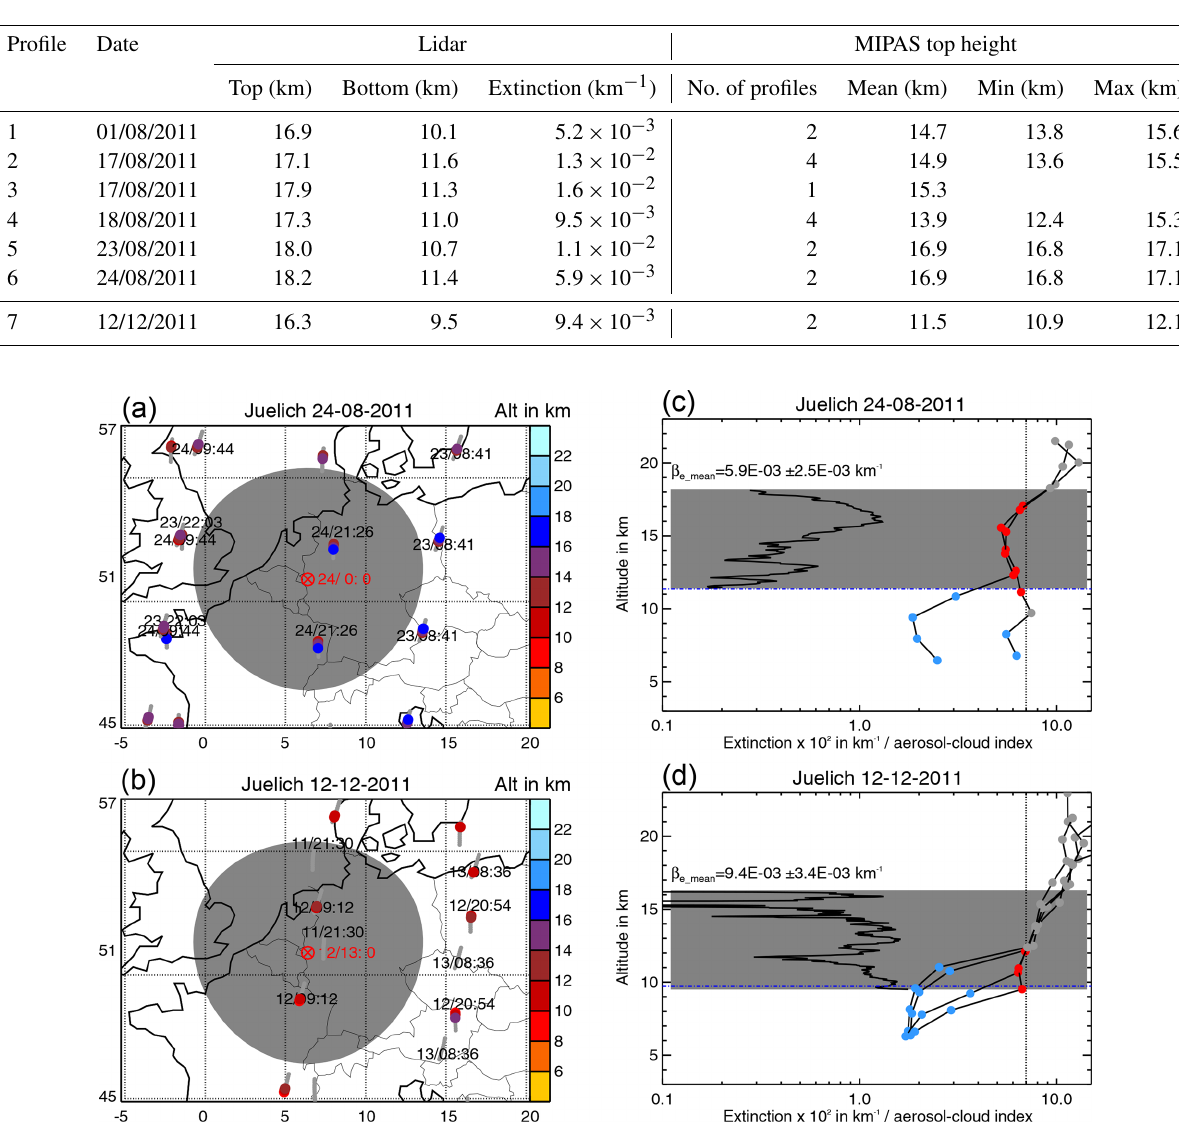
Figure 12. Nabro aerosol measured by the Jülich lidar and MIPAS on (a, c) 24 August 2011 and (b, d) 12 December 2011. (a, b) The maps show the lidar station, lidar measurement time, match radius, MIPAS orbits, MIPAS profile measurement time, and MIPAS cloud top heights (colour coded). (c, d) Jülich lidar extinction profile at 355nm (black line) between aerosol top and bottom altitude (grey box) and MIPAS ACI profiles. In the MIPAS ACI profiles the grey dots denote clear air, red dots sulfate aerosol, and blue dots denote ice and optically thick clouds. The black dotted line is the ACI threshold of